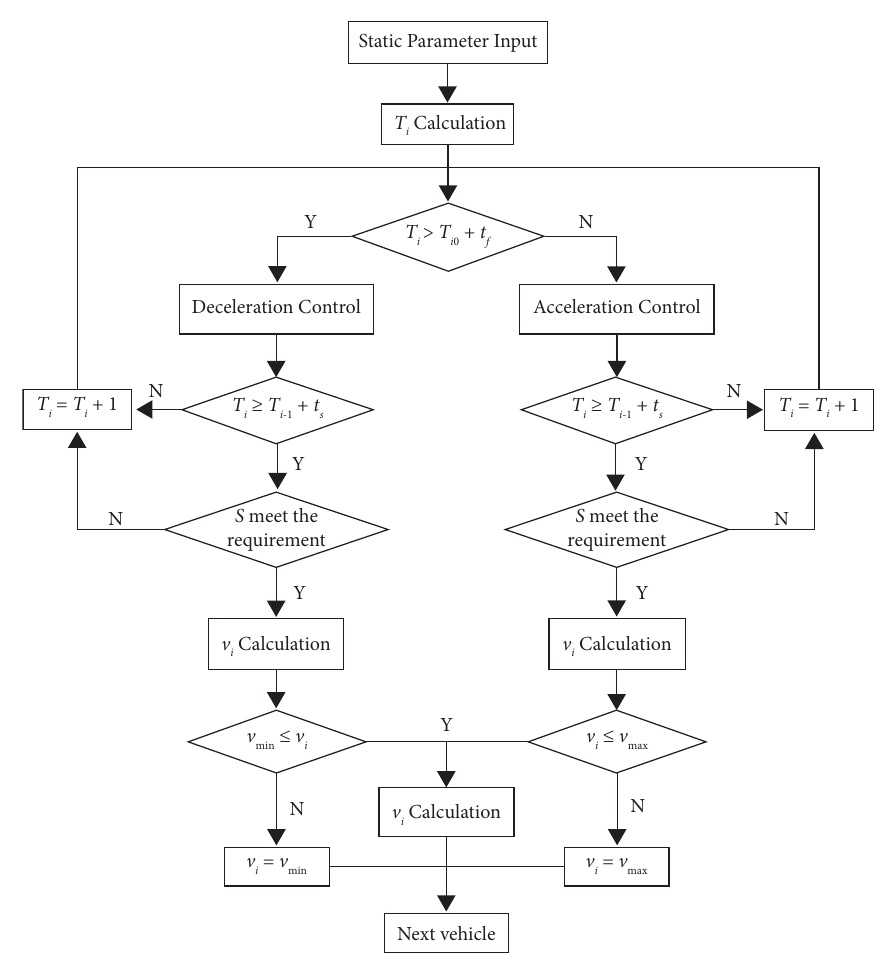
Figure 3: Flowchart for solving the speed control